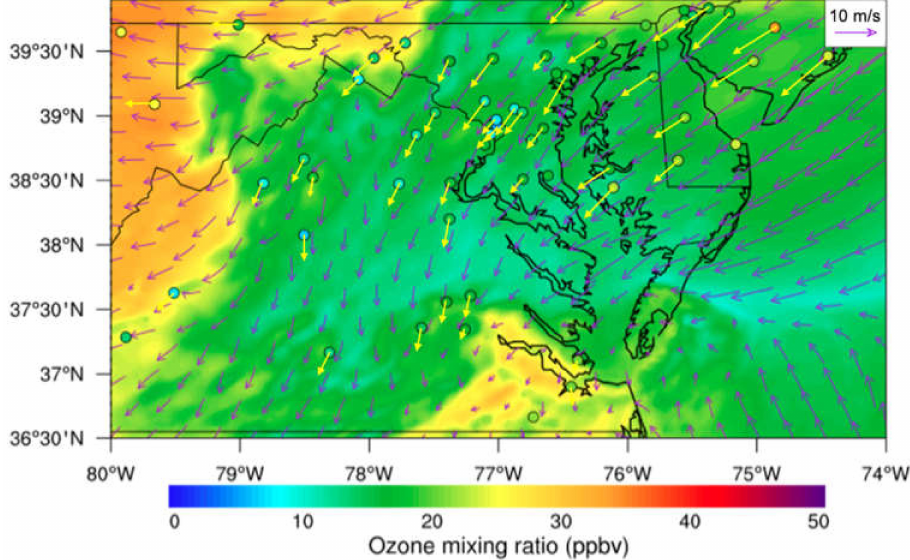
Figure 5. WRF–Chem-simulated surface O 3 mixing ratios and EPA AirNow observed surface O 3 mixing ratios (color-filled circles) at 1500 UTC on 3 June 2015. The purple streamlines are the simulated surface winds, while the yellow ones are EPA AirNow observed surface winds. Wind magnitude is indicated by the length of the streamline shown in the top-right insert; units, m s − 1